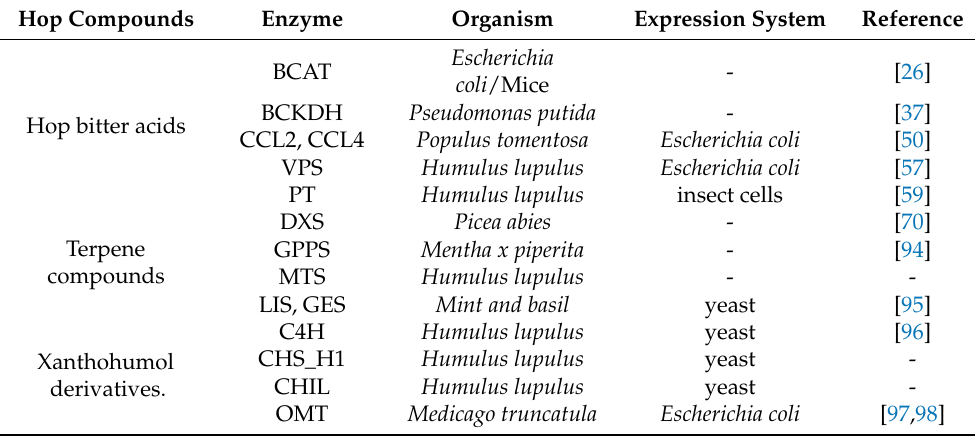
Table 1. Research closely related to the key enzymes involved with the phytochemical compound’s biosynthesis in